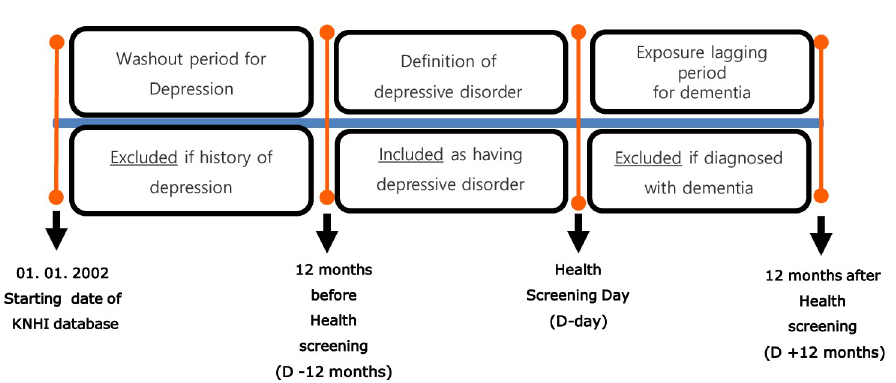
Fig 1. Definition of depressive disorder, washout for dementia and depressive disorder, and exposure lagging for dementia (KNHI: Korean National Health Insurance).